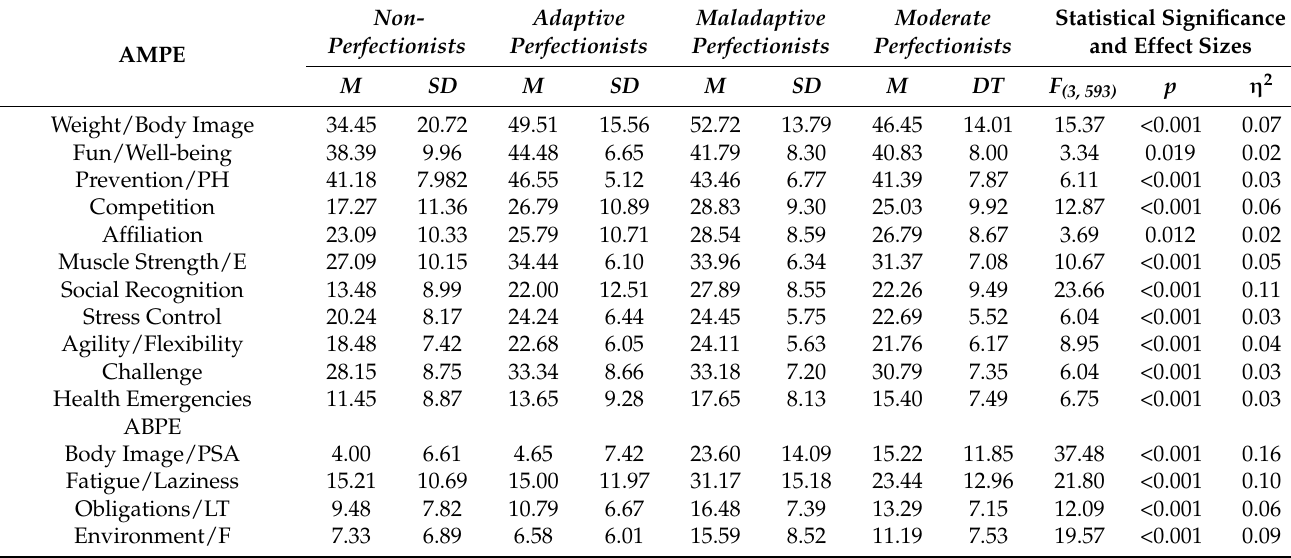
Table 2. Multivariate analysis of variance (ANOVA) of participation motives and barriers to exercising by perfectionism profiles.